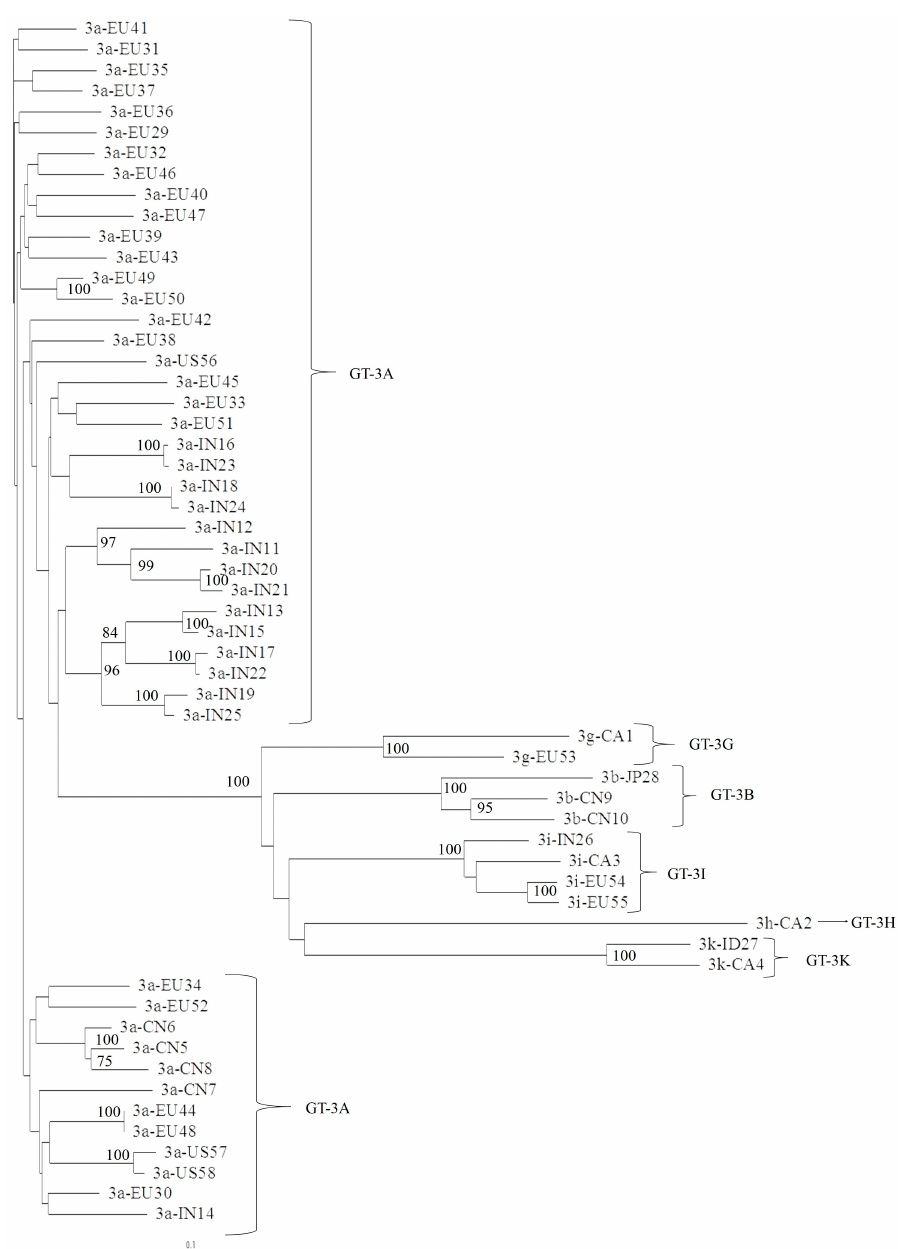
Figure 6. Phylogenetic tree of the NS5B region of 58 complete genomes retrieved from the Los Alamos database. The maximum-likelihood phylogenetic rooted tree of the NS5B region shows the relationships between different GT-3 subtypes of 58 isolates that had full genomes available. The geographic origin of each isolate is indicated by a code, followed by a progressive number. The geographic codes are: BR = Brazil, EU = Europe, US = USA, AU = Australia, CA = Canada, PK = Pakistan, IN = India, TH = Thailand, CN = China, ID = Indonesia, and JP = Japan. Evolutionary distances are indicated next to the branches.